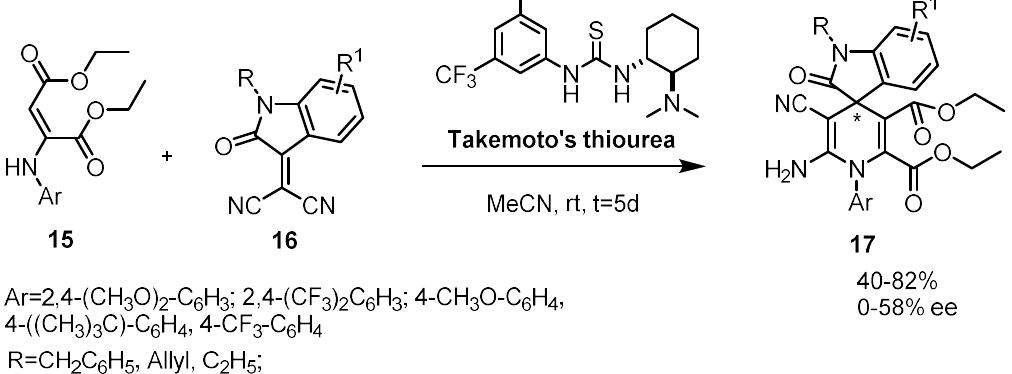
Table 8. Takemoto’s thiourea catalysed synthesis of spirocyclic1,4-DHPs 17 [62].